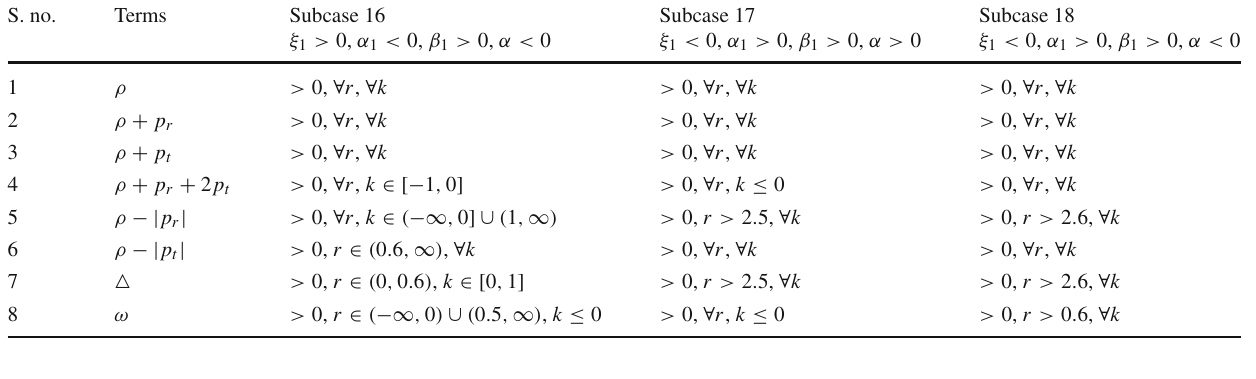
Table 5 Results for Model-I: (cid:2) e ξ ρ = α + β 1 R 1 R 1 R